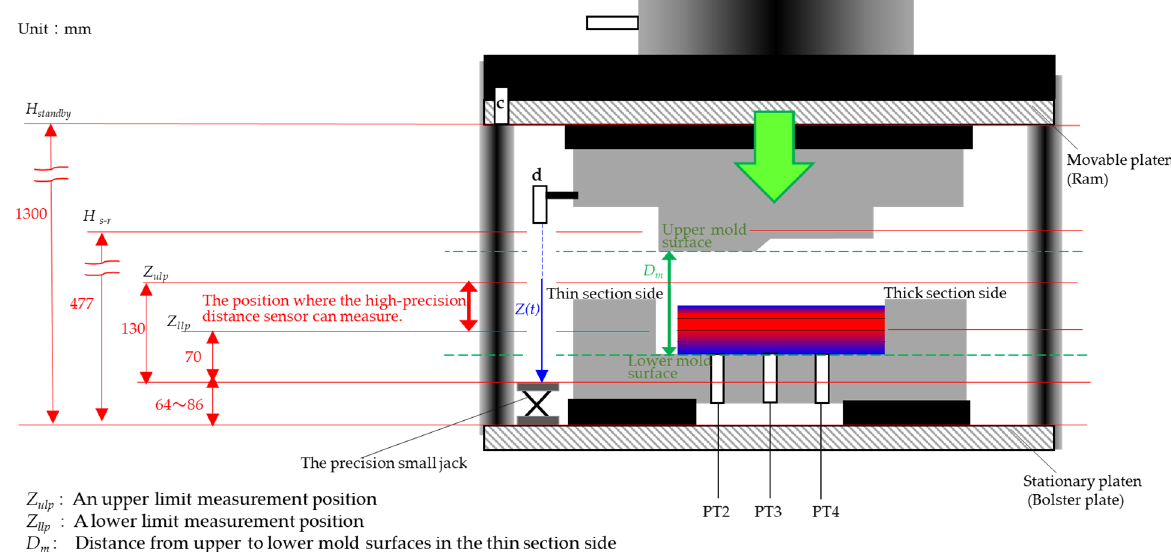
Figure 6. Schematic illustration of the upper mold position and measurement of distances between the upper mold surface and the lower mold surface during upper mold downward movement using the high-precision distance sensor ( c. the long-distance sensor, d. the high-precision distance sensor).